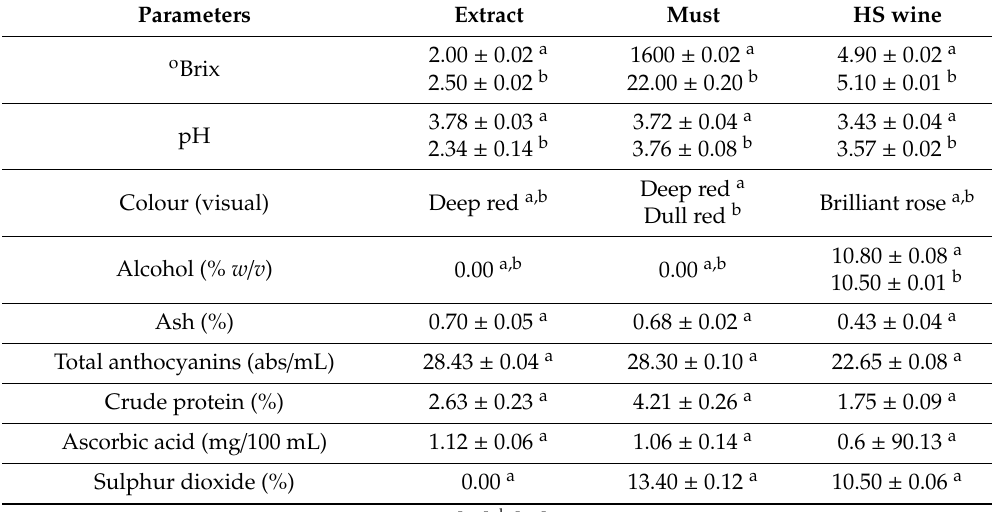
Table 5. Physico-chemical parameters of di ff erent Hibiscus sabdari ff a extracts, must, and wine according to the